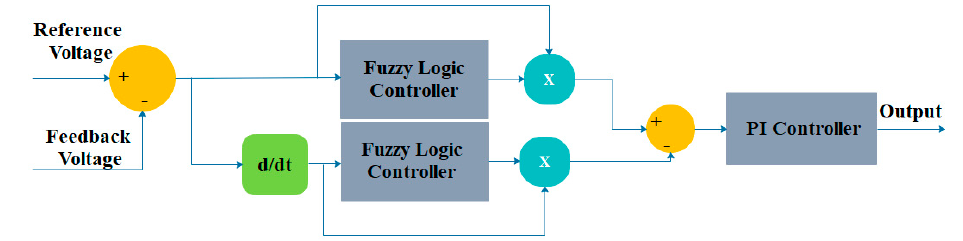
Figure 33. Voltage control block for type 4 hybrid controller.